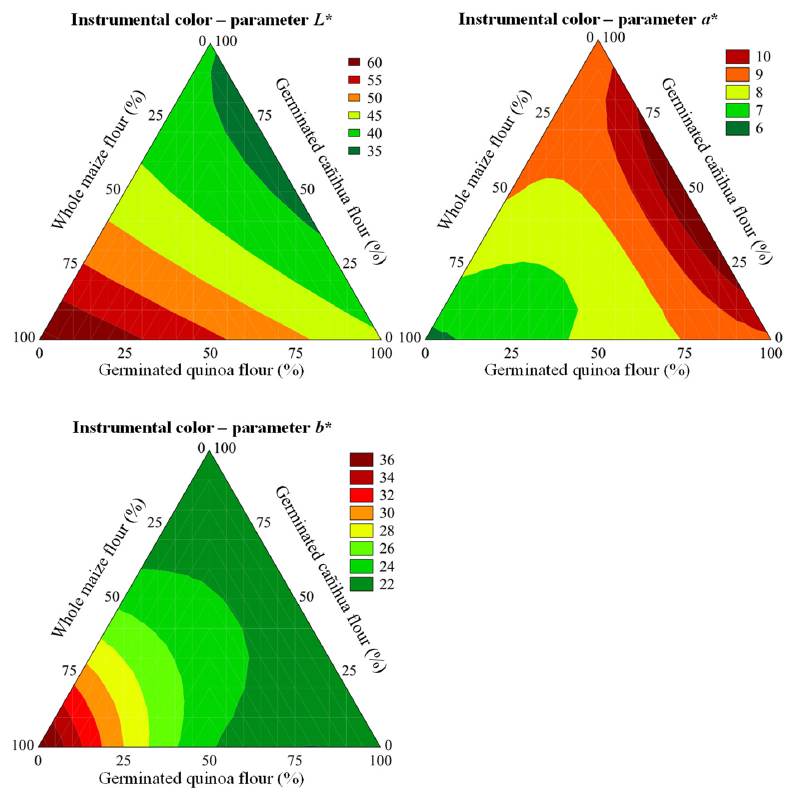
Figure 5. Contour plots predicted for instrumental color parameters ( L *, a *, b *).